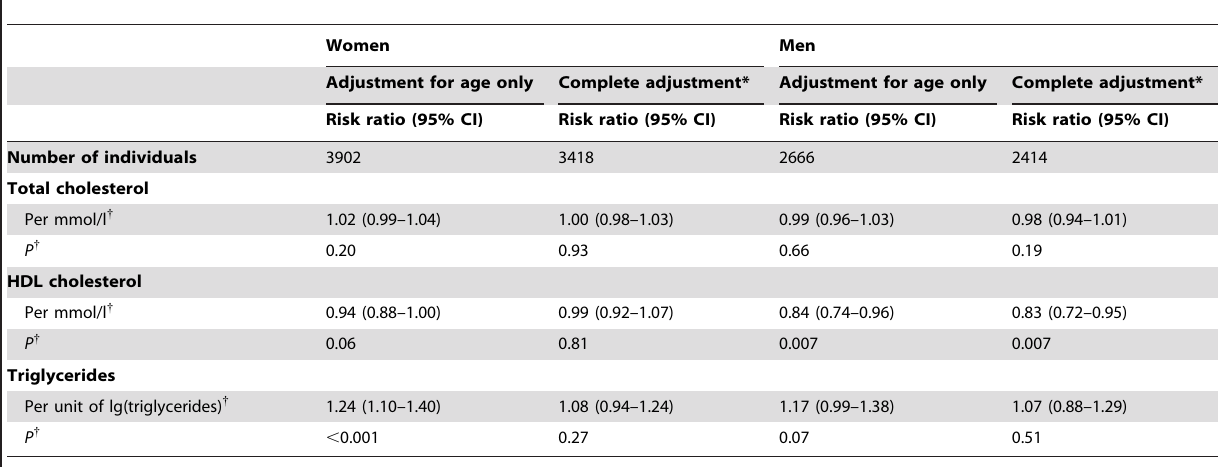
Table 4. Log-linear associations between lipid levels and probability of chronic LBP among individuals with chronic LBP at